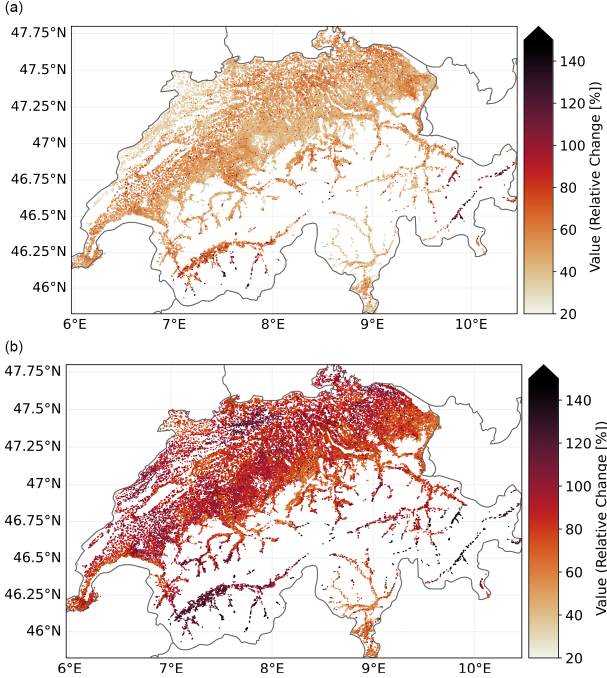
Figure 7. Maps showing the relative increase in the loss of labour productivity due to heat compared to the baseline for the year 2050 under the RCP2.6 (a) and the RCP8.5 (b) scenarios for the high physical activity